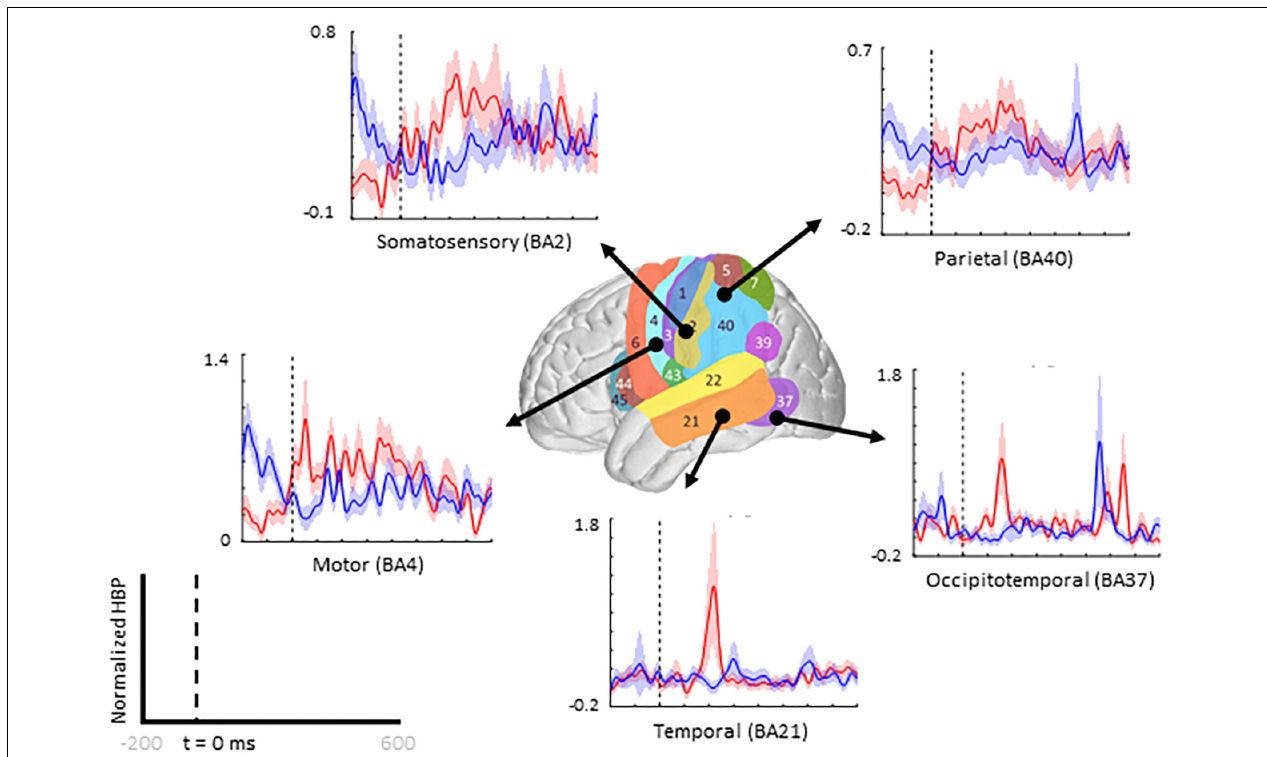
FIGURE 4 | Increased HBP in multiple cortical areas during motor imagery error. The brain in the center shows the spatial range for each Brodmann Area available in our subject population, with each area labeled by their corresponding number. Each plot shows the average response within the specified Brodmann Area during erroneous decoding (red) and during correct decoding (blue), 100 to 500 ms after error onset (indicated by the vertical dashed